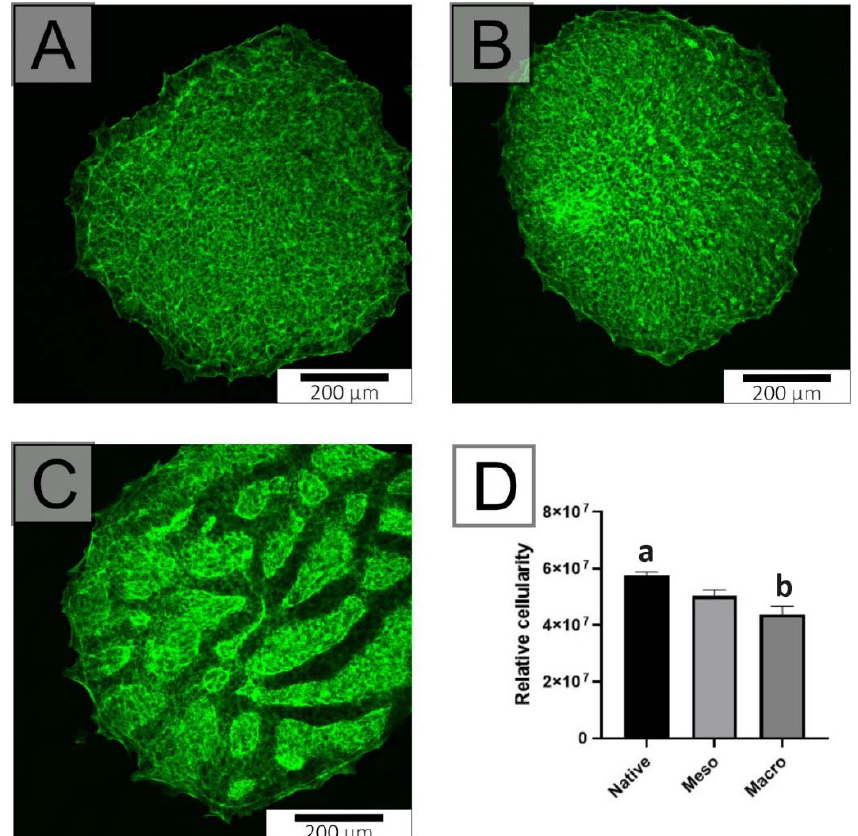
Figure 3. hiPSC cultivated on native ( A ), meso-structured ( B ), and macro-structured ( C ) substrates after four days and counterstained by Phaloidin-FITC. It is clear that all substrates allow cell adhe- sion and growth. The graph ( D ) shows slightly lower cellularity on the macro-structured substrate four days after seeding. The different superscripts (a/b) express significant differences ( p ≤ 0.05).